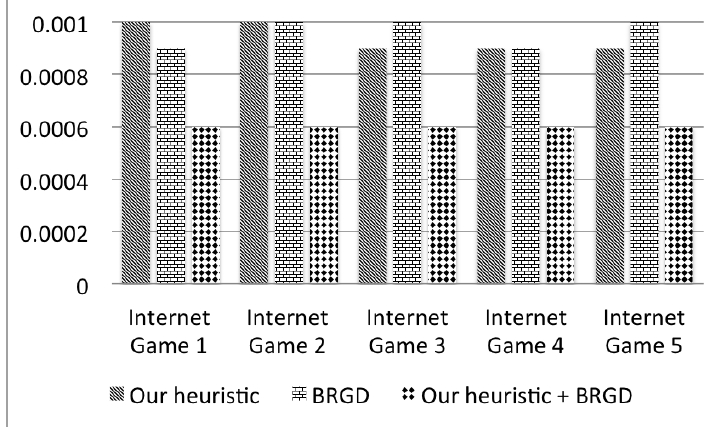
Figure 14. Combing BRGD and the Hybrid BRGD-SBRD Heuristic. Internet Games: BRGD Improvement ( y -axis represents the (cid:101)